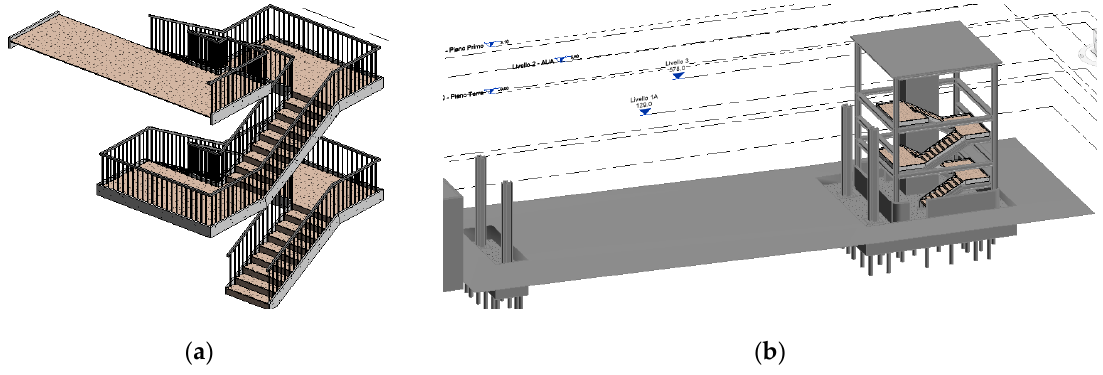
Figure 4. Elevation structures model: ( a ) flight of stairs; ( b ) stairwell structure.